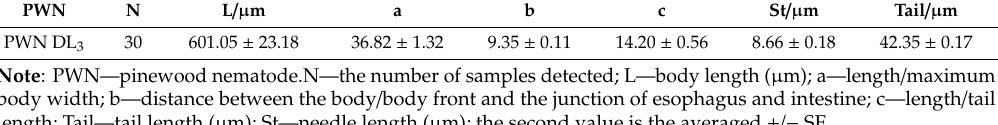
Table 1. Morphological measurements of third ‐ stage dispersal juveniles of pinewood nematode isolated from P. tabuliformis in Fushun.